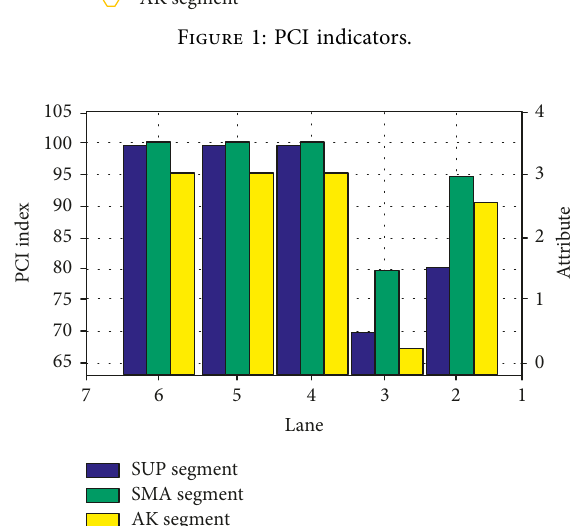
Figure 2: Converted PCI